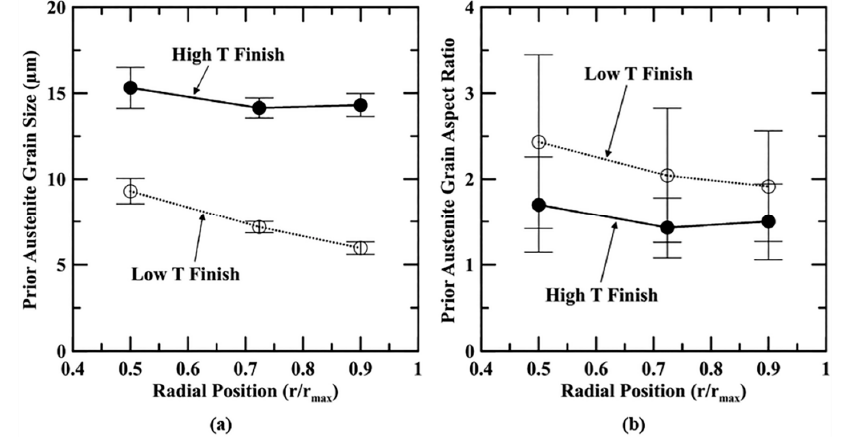
Figure 11. Prior austenite grain ( a ) size and ( b ) aspect ratio with respect to radial position determined for microstructures produced via High T Finish and Low T Finish simulations. The error bars represent one standard